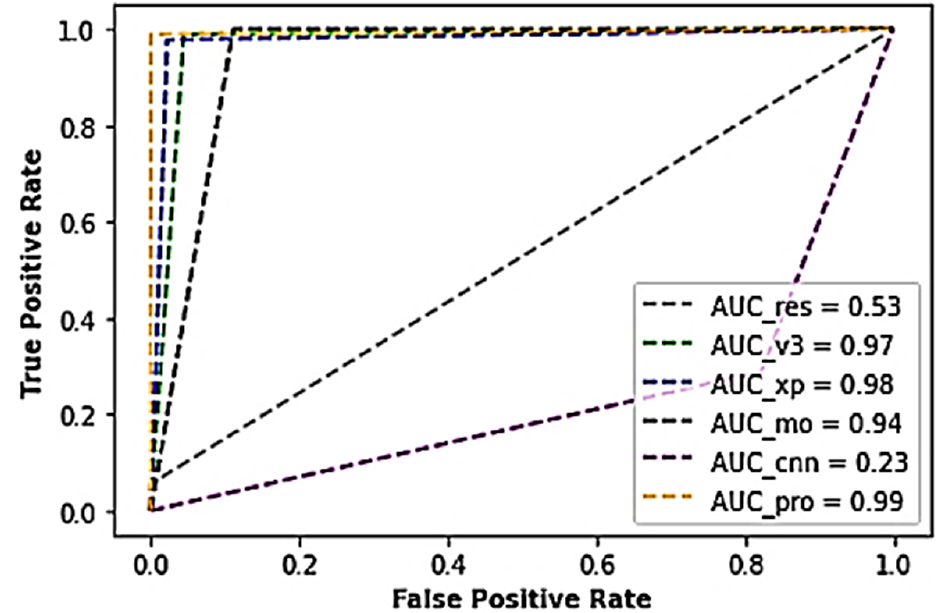
Figure 5. A cross-section of the AUC-ROC results of the industrial PCB dataset.